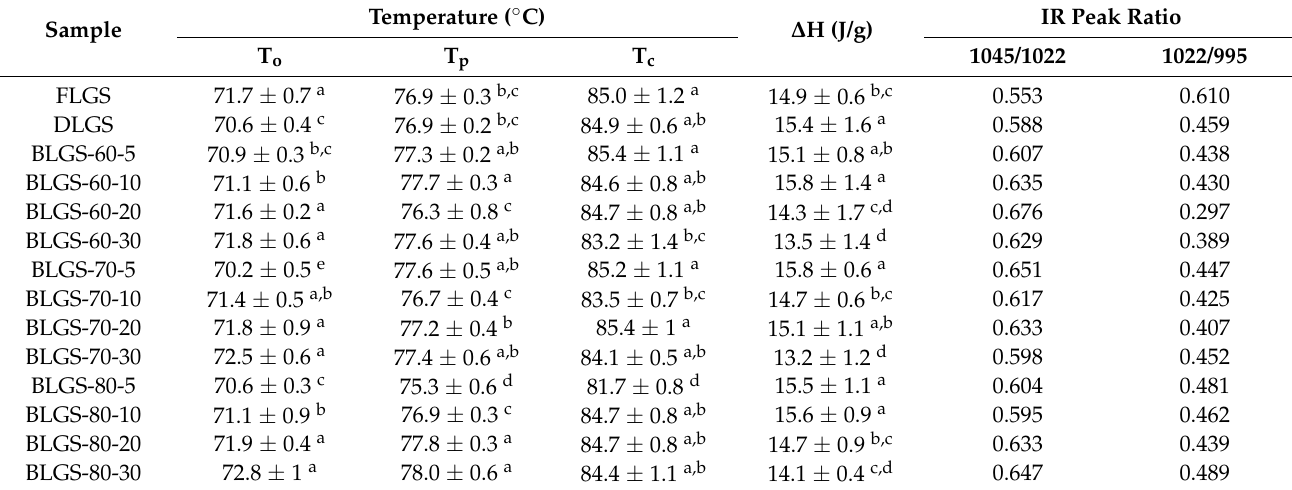
Table 1. Thermal properties and IR peak ratios of longan seed starch of different preparation conditions.